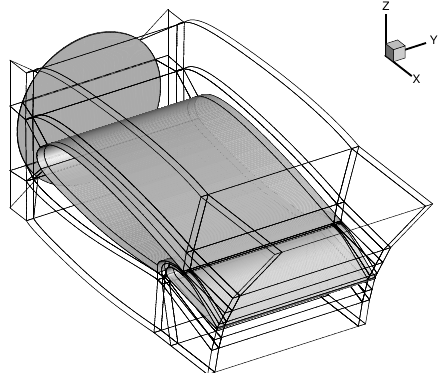
Figure 2. Grid blocks near the